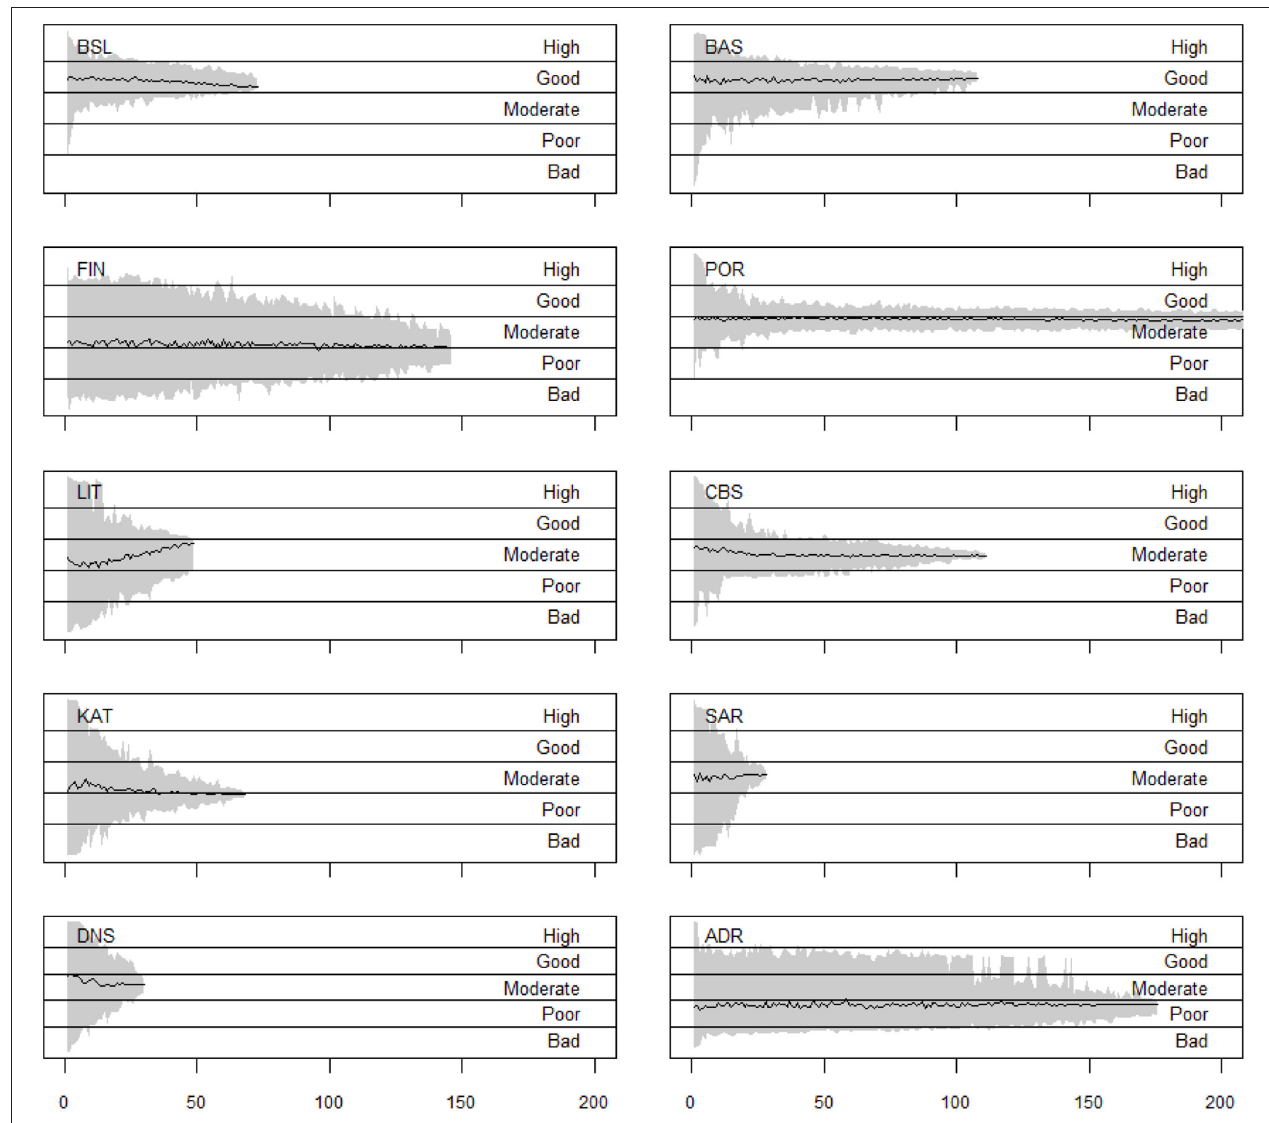
FIGURE 6 | Variation of the overall assessment results in the case studies, if only a subset of the indicator values is taken into account. The x axis indicates how many indicators are included into the assessment, and the gray area spans the assessment result values that emerged. The black line shows the mean assessment result across the 100 runs conducted for each number of indicator values. Note that the x axis goes only up to 200 indicator values; the Portuguese continental subdivision study included 466 indicator values in